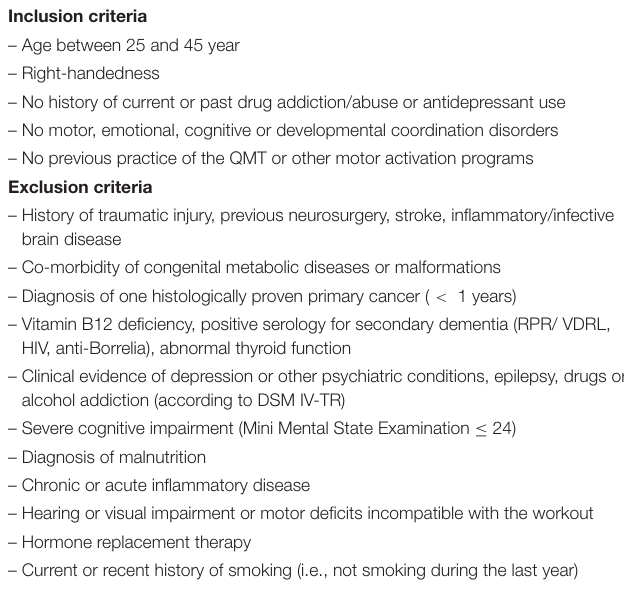
TABLE 1 | Inclusion and exclusion criteria of the present